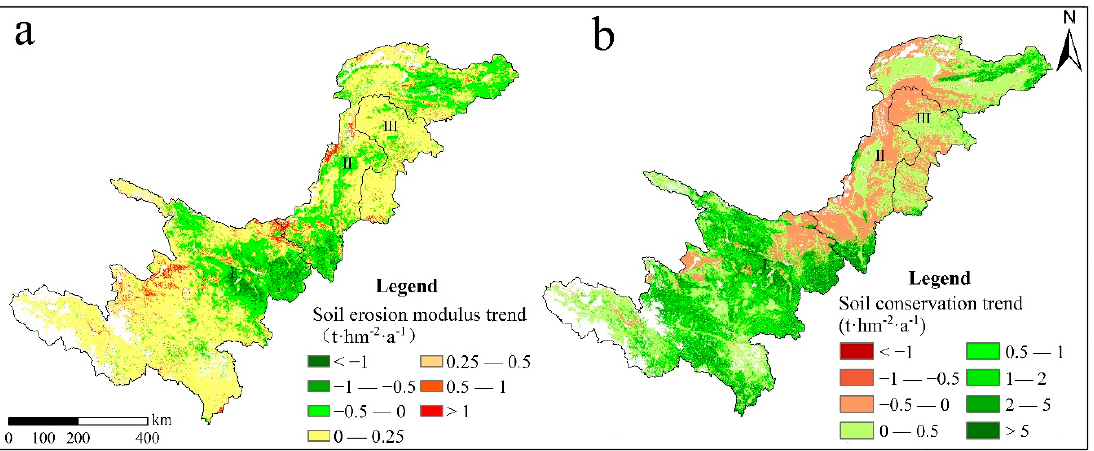
Figure 5. Spatial distributions of the soil erosion modulus ( a ) and soil retention ( b ) change rates in the Upper Yellow River region.